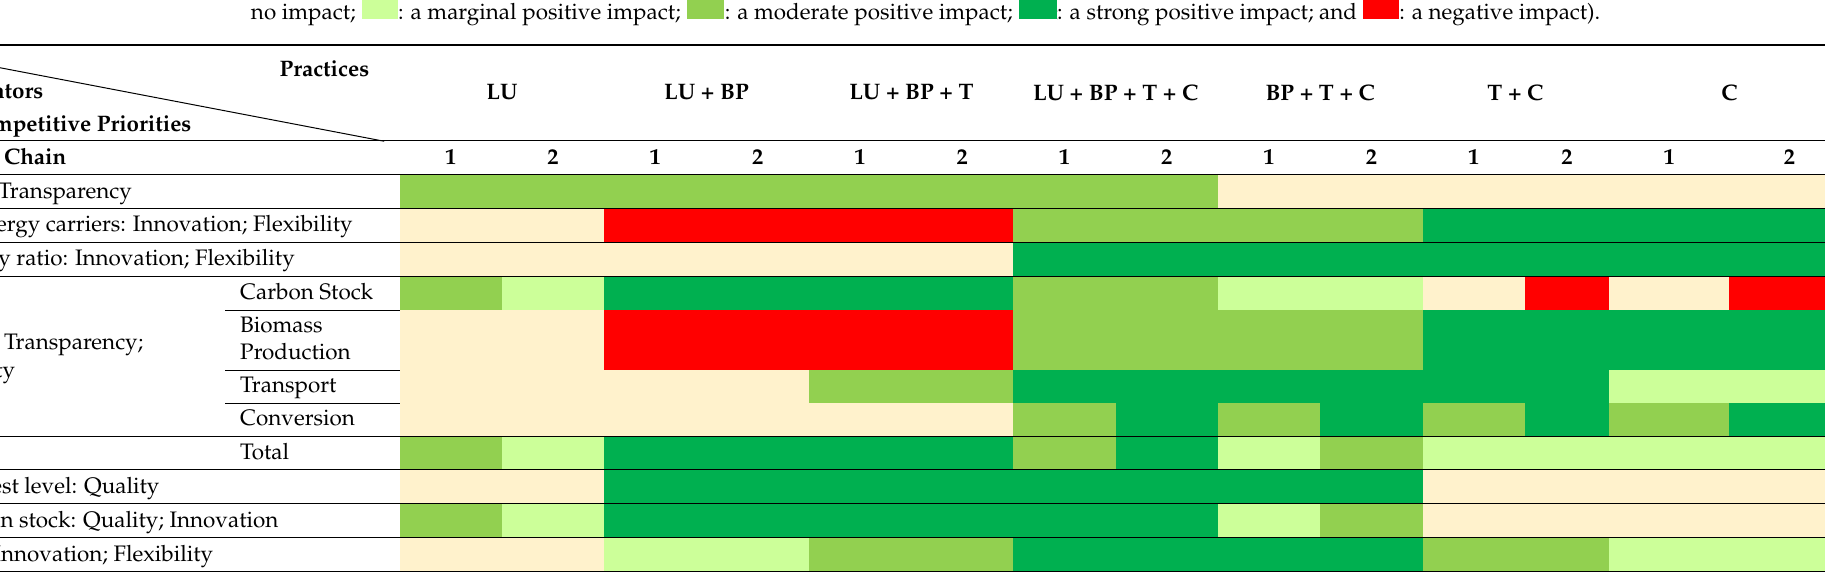
Table 4 . Qualitative transcription of indicator results ranking competitive priorities per scenario compared to a base case (colour codes are defined as having: